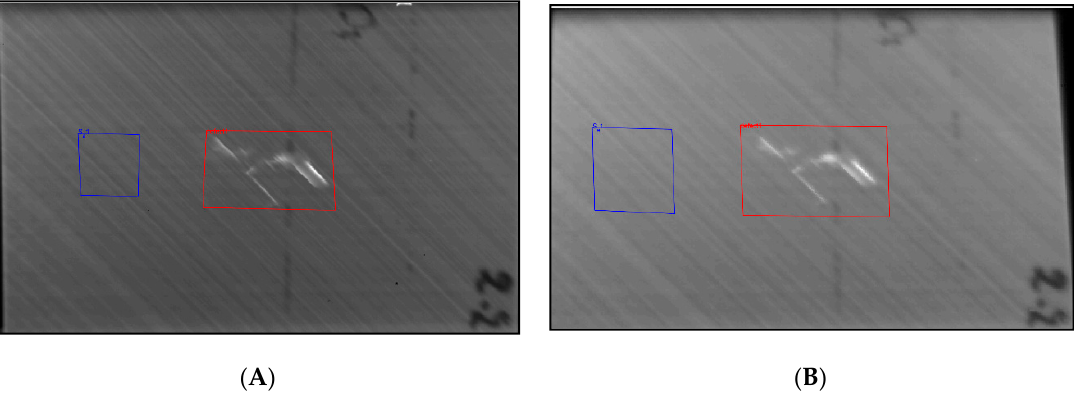
Figure 12. ( A ) 2.2.Cooled Front , selecting areas of the damaged and sound areas. ( B ) 2.2.Uncooled Front , selecting areas of the damaged and sound areas.